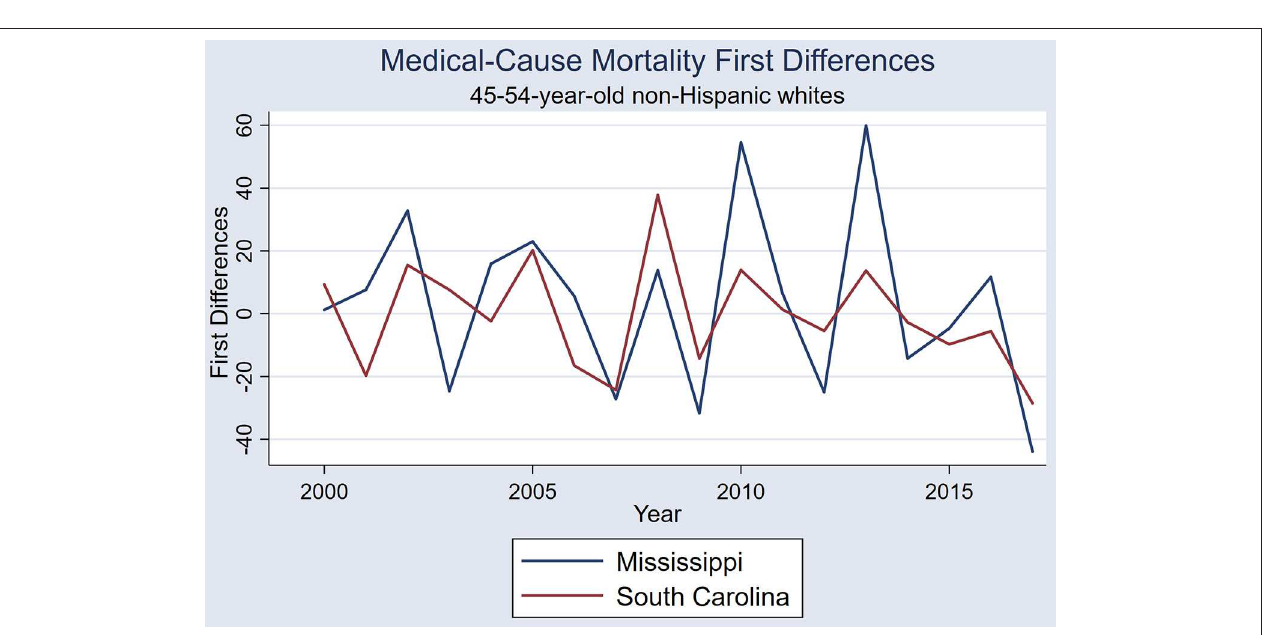
FIGURE 2 | First differences of annual medical-cause mortality rates in the six states: Alabama, Arkansas, Louisiana, Mississippi, Oklahoma, and South Carolina.